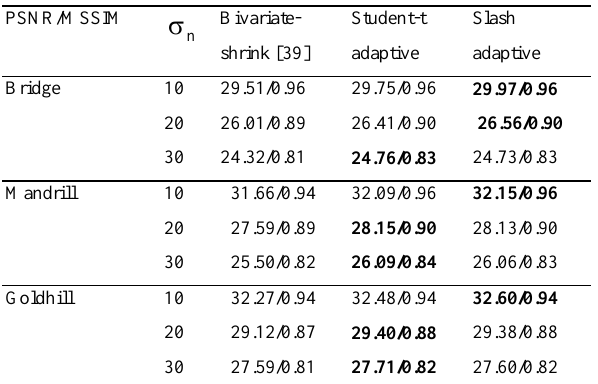
Table 3. PSNR and MSSIM comparison of performance for image denoising in the orthogonal wavelet transform